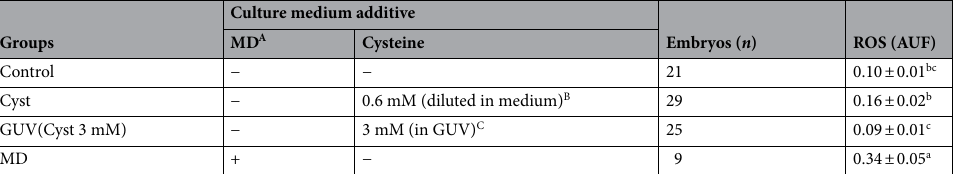
Table 4. Intracellular concentrations of reactive oxygen species (ROS) in bovine embryos cultured in vitro in medium supplemented with giant unilamellar vesicles (GUVs) and cysteine (Cyst) and subjected to menadione (MD)-induced oxidative stress. Data are expressed as the mean ± standard error of four independent replicates. A Embryos were cultured for 7 days, and menadione (5.0 μM or 7.5 μM) was included in the medium only on the sixth day of culture (from D6 to D7). B In the Cyst group, cysteine was diluted directly into the culture medium at the final concentration of 0.6 mM. C In the GUV(Cyst 3 mM) group, the GUVs were electroformed in a solution containing 3 mM cysteine (5X solution) and subsequently diluted in the culture medium (20% v/v) in order to obtain a maximum final concentration of cysteine in the medium of 0.6 mM after complete content release from the GUVs. ROS concentrations are expressed as arbitrary units of fluorescence (AUF). abc Different letters in the column indicate significant differences ( P < 0.05).